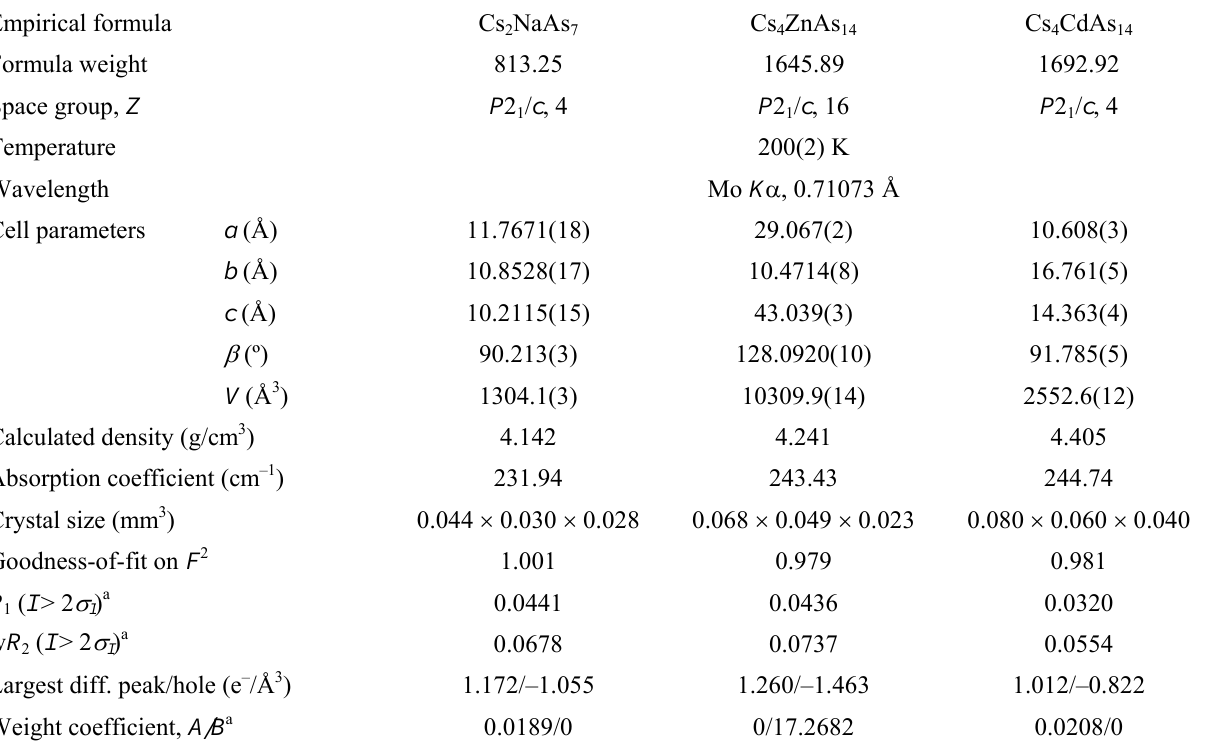
Table 1. Selected crystal data and structure refinement parameters for Cs Cs ZnAs , and Cs CdAs 4 14 4 14